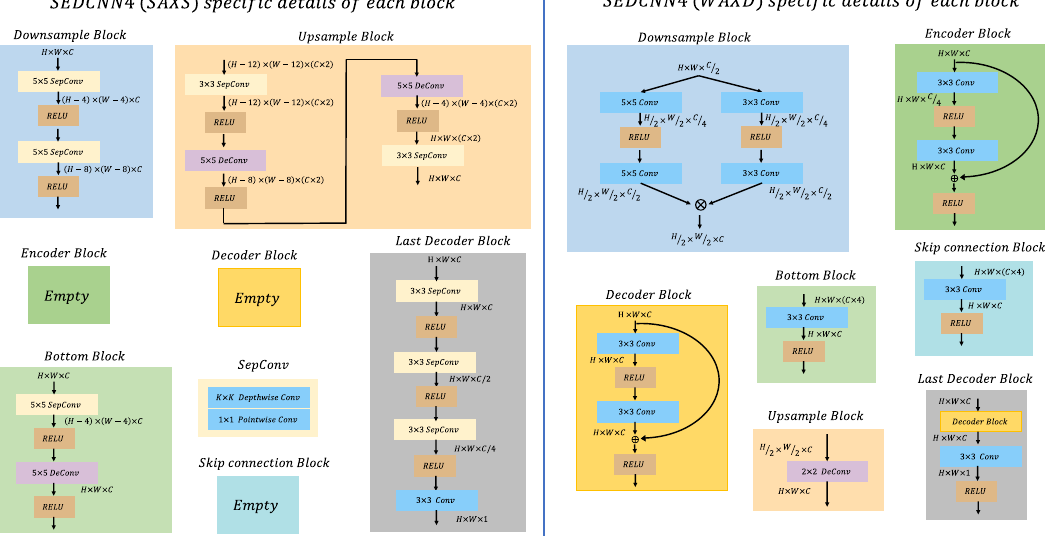
Fig. 2 Structure inside the Stage blocks. SAXS and WAXD part separately shown with breakdown of each Stage block ’ s structure, unveiling its CNN-based network design. Table 1. Performance of SEDCNN2 and SEDCNN4 compared to REDCNN and PMRID after 500 epochs.